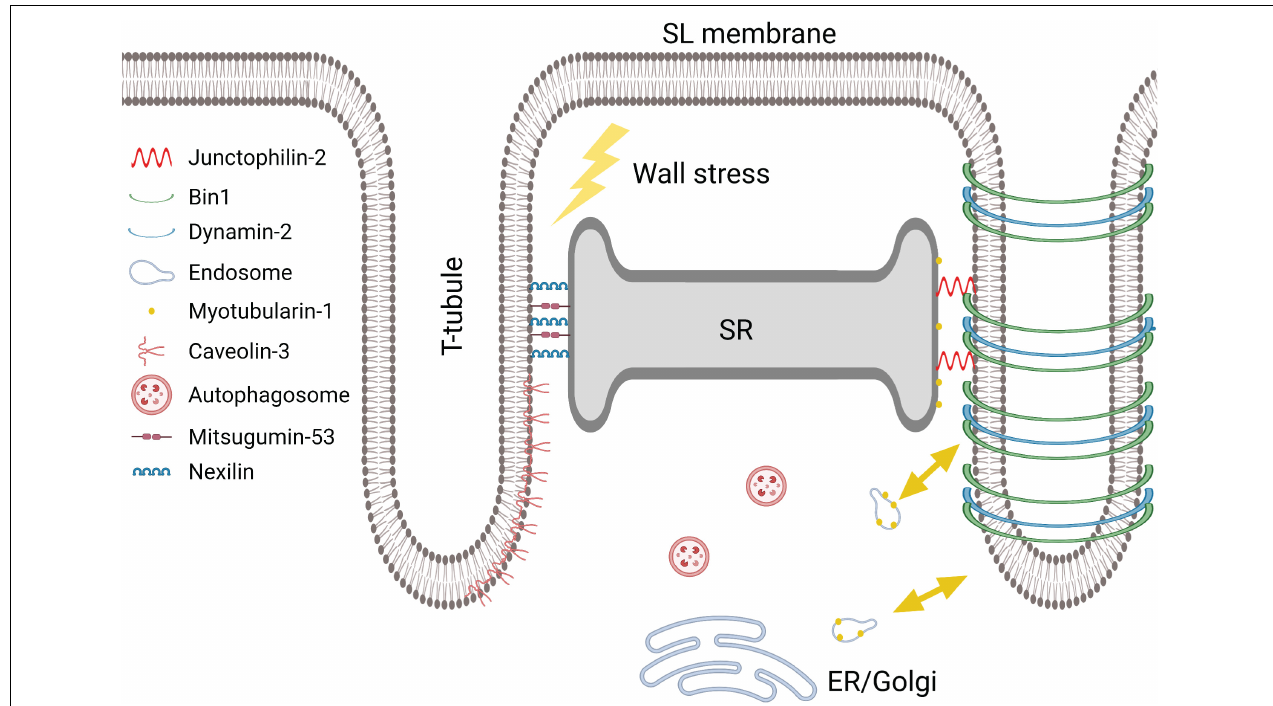
FIGURE 5 | Proposed proteins and pathways involved in dyadic biogenesis, maintenance, and disruption. Created with BioRender.com.